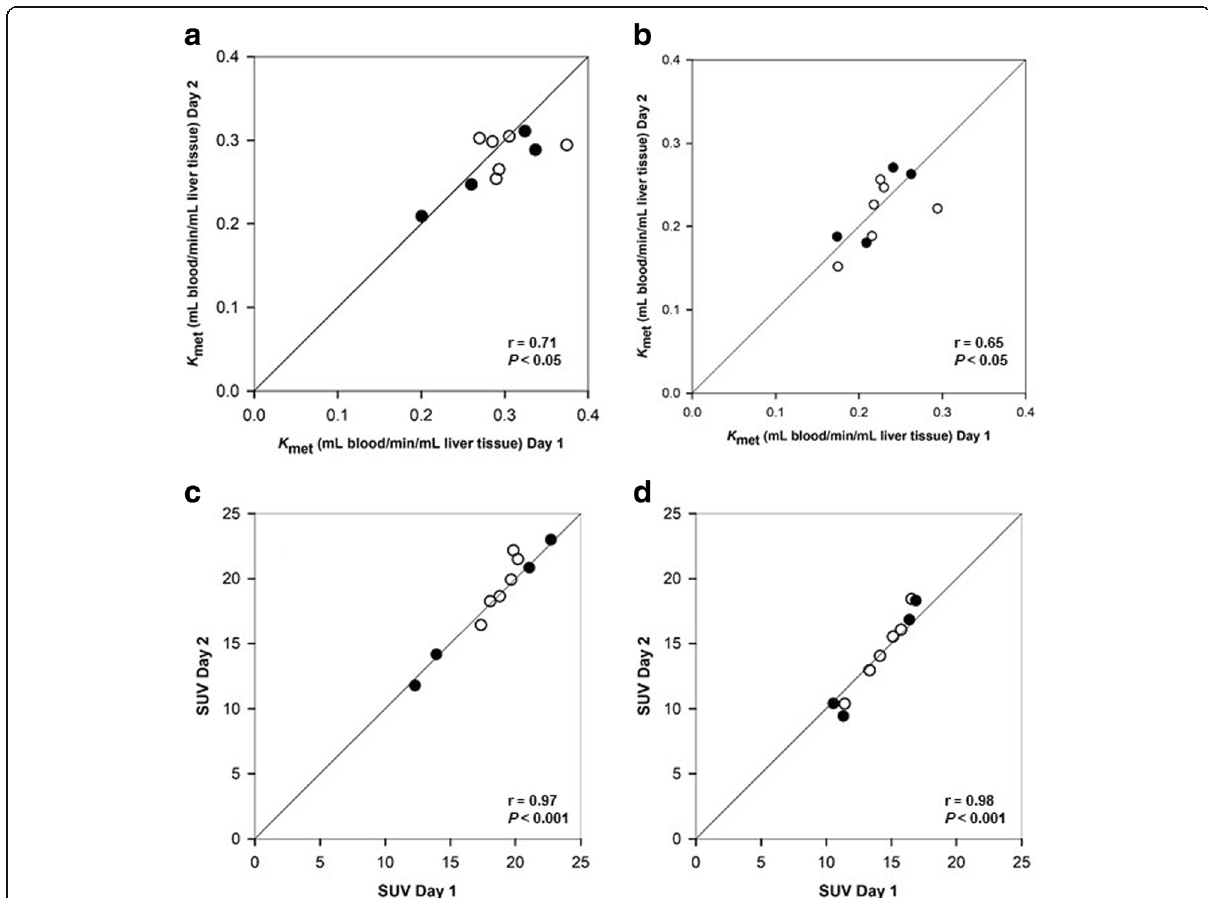
Fig. 1 Correlations between K met and SUV of 18 F-FDGal for paired measurements in patients with cirrhosis (black circle) and healthy subjects (white circle). Regional VOI values ( a , c ) and whole-liver VOI values ( b , d ) for the reconstruction algorithm with resolution modelling and a 168 matrix are shown with lines of